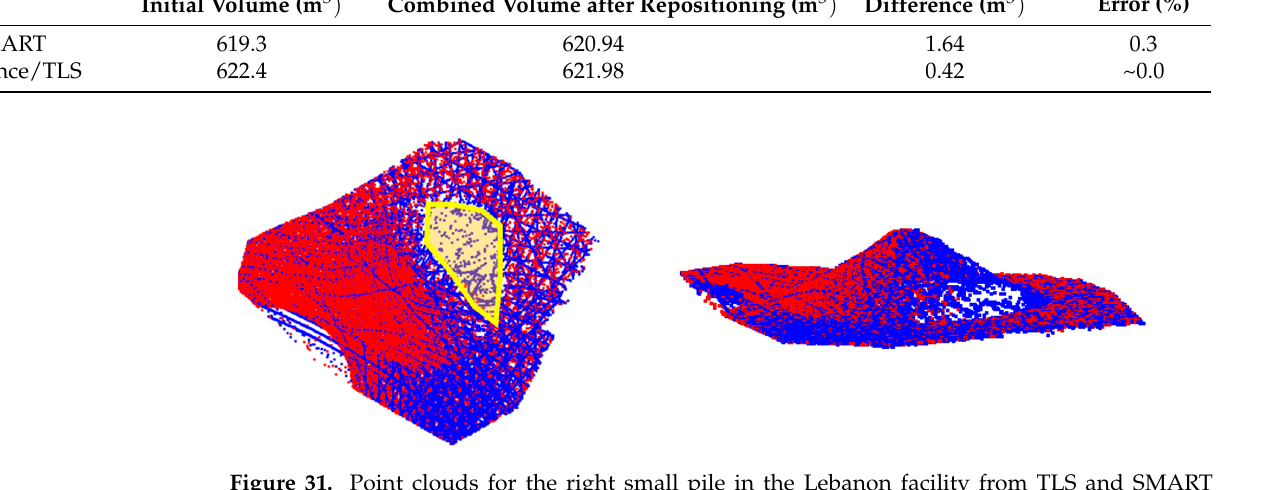
Table 9. SMART and TLS volume estimates for the left pile before/after repositioning.